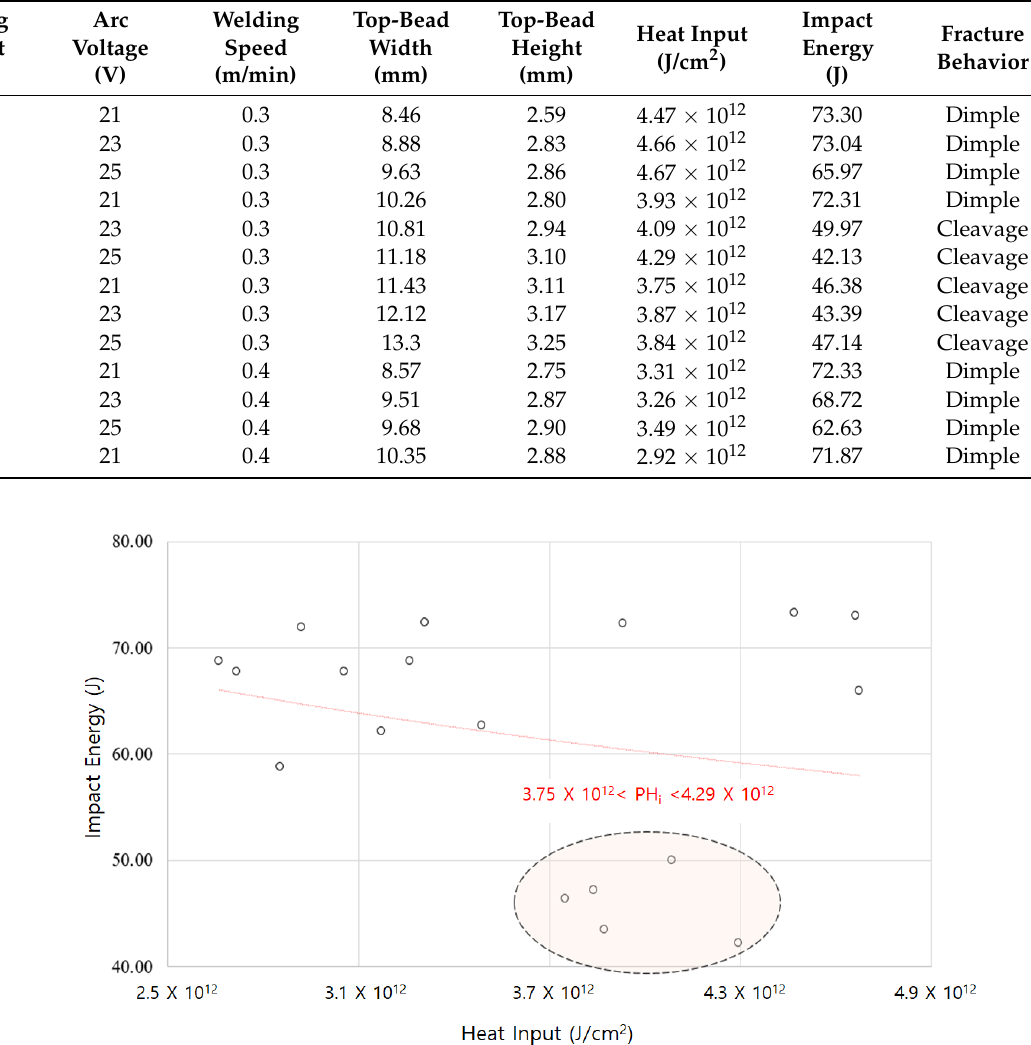
Table 9. Brittle fracture behavior data for discriminant analysis in flux core arc welding.